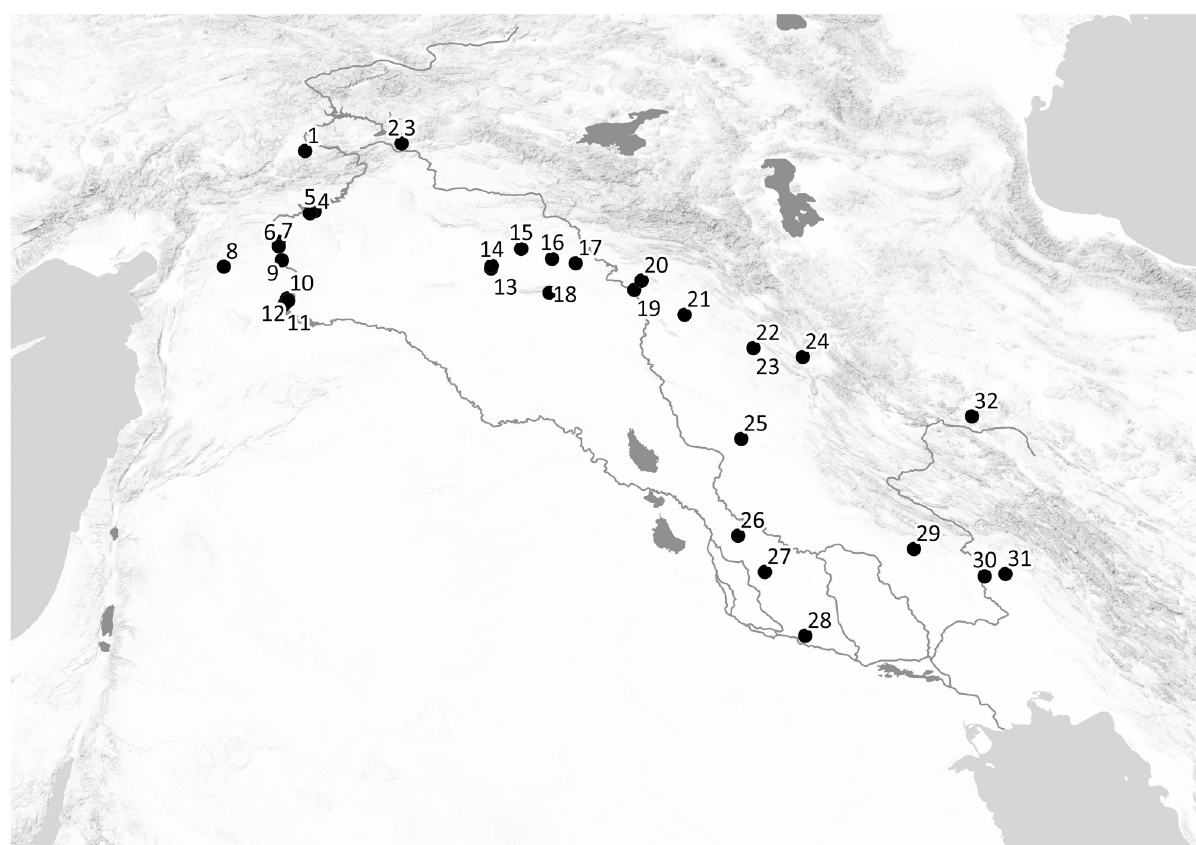
Fig 1. Location of the main investigated Late Chalcolithic sites in greater Mesopotamia. 1. Arslantepe; 2. Tepecik; 3. Nor ş untepe; 4. Samsat; 5. Kurban Ho¨yu¨k; 6. Hacınebi Tepe; 7. Zeytinli Bahc¸e Ho¨yu¨k; 8. Oylum Ho¨yu¨k; 9. Jerablus Tahtani; 10. Jebel Aruda; 11. Habuba Kabira South; 12. Tell Sheikh Hassan; 13. Tell Brak; 14. Tell Feres al-Sharqi; 15. Tell Leilan; 16. Tell Hamoukar; 17. Tell el-Hawa; 18. Grai Resh; 19. Nineveh; 20. Tepe Gawra; 21. Surezha; 22. Logardan; 23. Girdi Qala; 24. Gerdi Resh; 25. Tell Rubeidheh and Tell Hassan; 26. Tell Uqair; 27. Abu Salabikh; 28. Uruk; 29. Teppe Farukhabad; 30. Susa; 31. Chogha Mish; 32. Godin Tepe. Map: M. Karaucak through the topographic data courtesy of Shuttle Radar Topography Mission (SRTM),